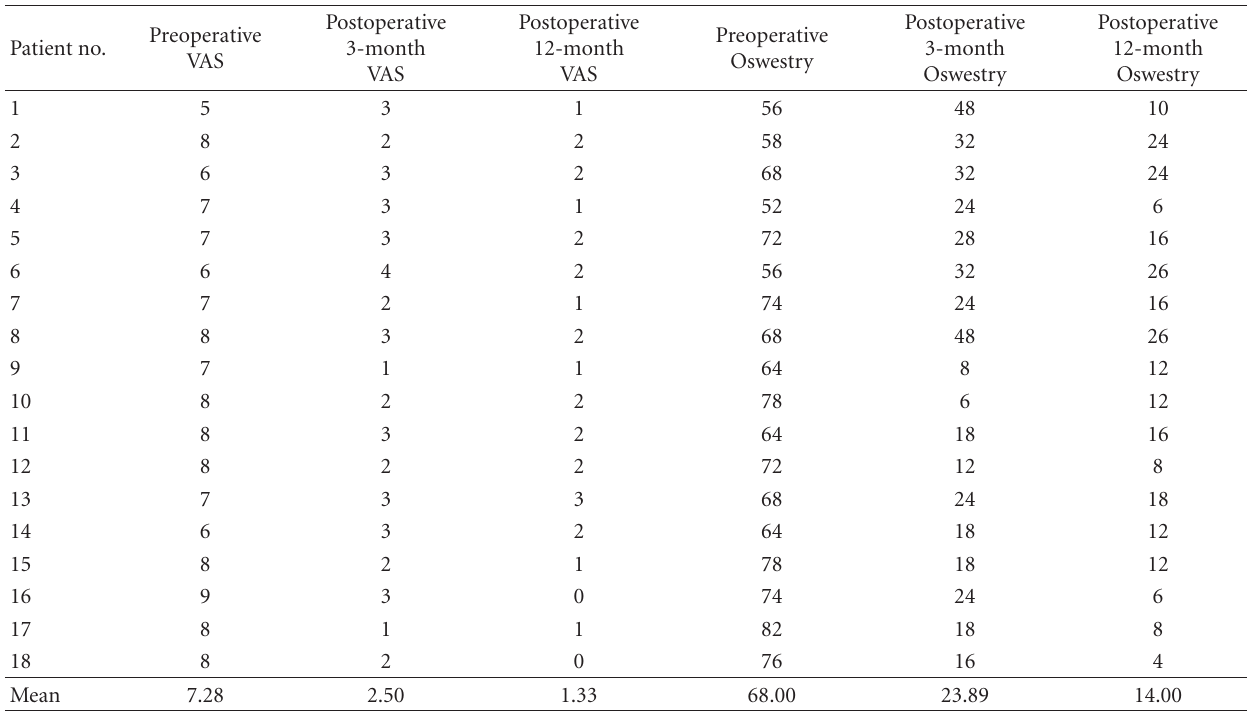
Table 2: Patient preoperative and postoperative